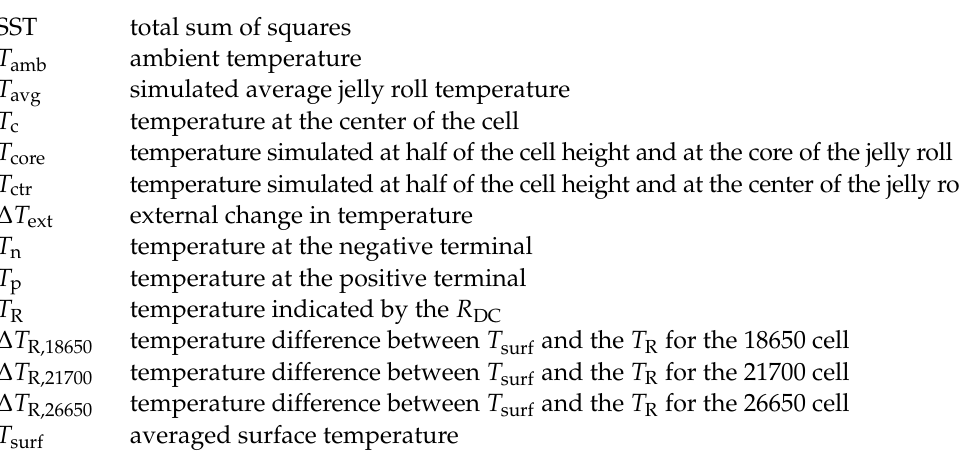
Si/Gr ( a ), 21700 with |